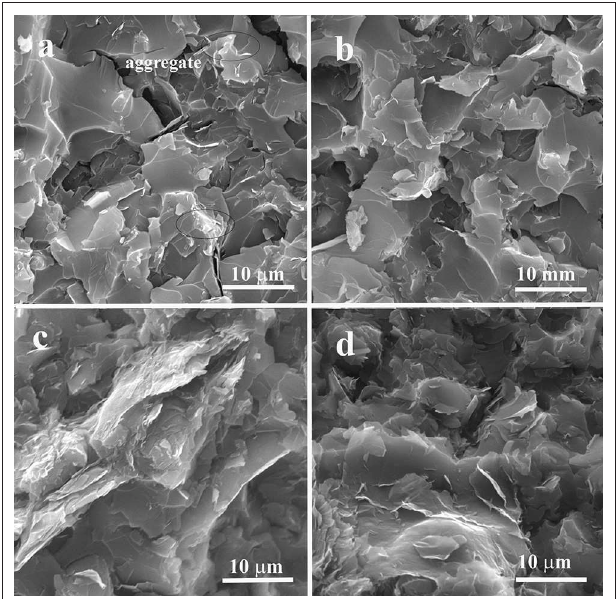
FIGURE 2 | SEM micrographs of ER/GNP loaded with 0.9 vol.% dispersed by (a) Method A and (b) Method B with 1.5 vol.% of GNP dispersed by (c) Method A and (d) Method B.